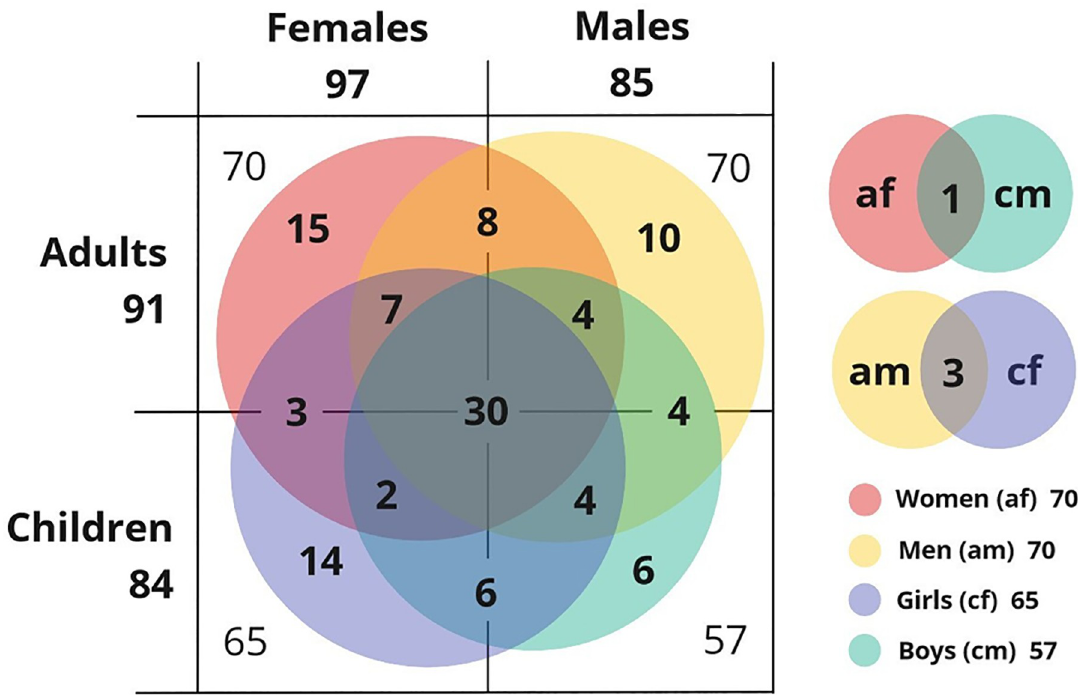
Fig 4. Venn diagram of WEP species shared by the four subsamples. Representation of the number and the distribution of WEP species cited by each subsample.